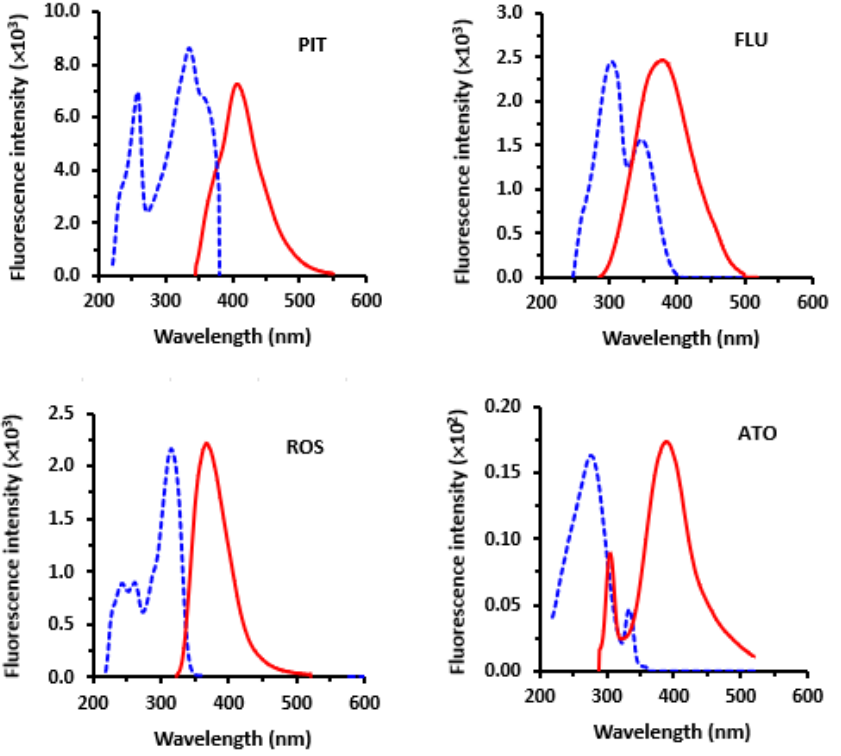
Figure 2. Excitation (-----) and emission (_____) spectra of the investigated statin solutions (10 µg mL –1 ). PIT, FLU, ROS and ATO are the abbreviations of pitavastatin, fluvastatin, rosuvastatin and atorvastatin, respectively.